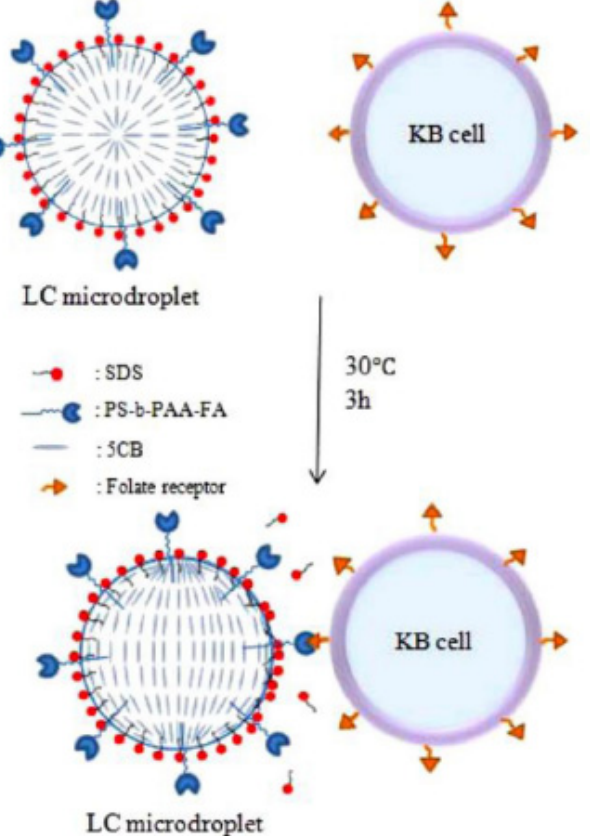
Figure 13. KB cancer cell (mouth epidermal carcinoma cell) interactions with LC micro droplets containing folic acid-conjugated PS-b-PAA [34].